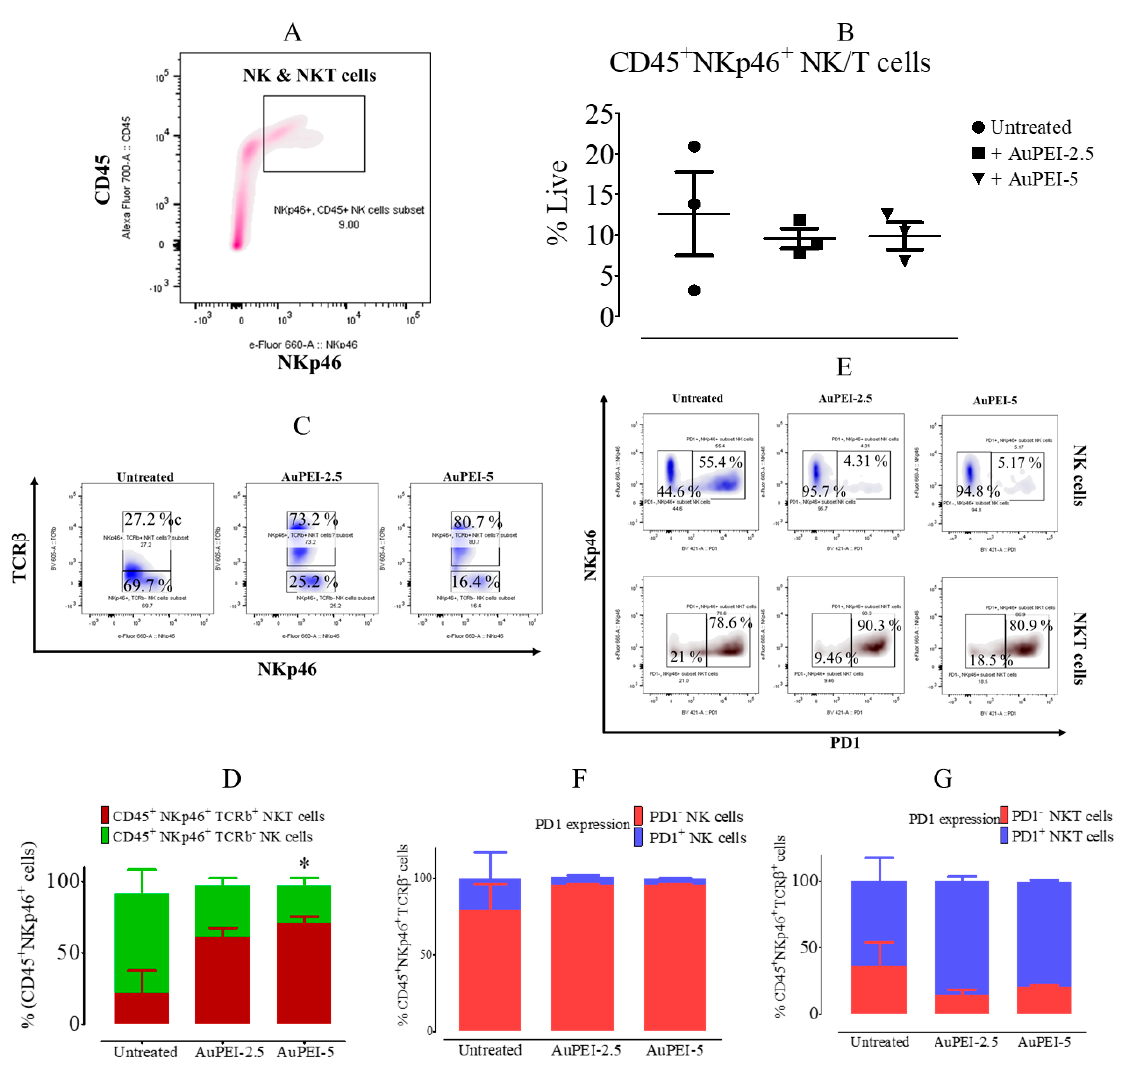
Figure 6. MET-1 tumor-infiltrating NK cell distribution upon AuPEI nanocomposite i.t. injection. MET-1-bearing mice were injected i.t. with 0.5 mg/mL Au (40 µL) AuPEI nanocomposites and euthanized 24 h after. ( A ) Gating strategy to differentiate NK/NKT cells within the tumor cell population. NK/NKT cells, CD45 + NKp46 + ; NK, CD45 + NKp46 + TCR β − ; and NKT cells, CD45 + NKp46 + TCR β + . ( B ) Percentage of total NK/NKT cell population in tumors. ( C ) Representative dot-plot and ( D ) summary of NK and NKT cell distribution within the total NK/NKT cell population. ( E ) Representative dot-plots show PD-1 expression by NK cells (upper) and NKT cells (lower); and a summary of PD-1 expression by ( F ) NK cells and ( G ) NKT cells. (Results are shown as mean ± SEM of n = 3 per condition; * p < 0.05 Mann–Whitney test, 95% confidence).